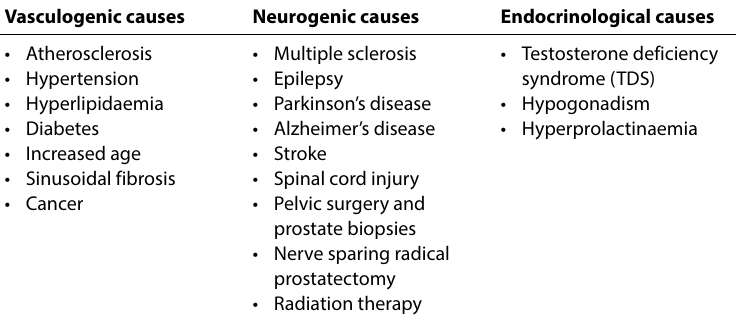
Table I. Organic causes associated with erectile dysfunction Vasculogenic causes